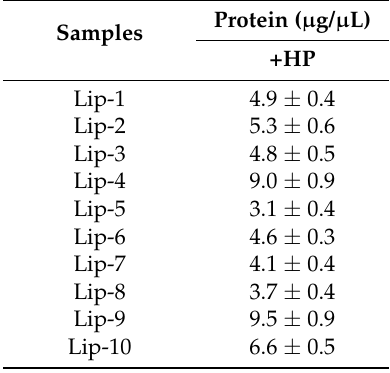
Table 3. Micrograms of proteins bound to liposomal formulations after 1-h incubation with